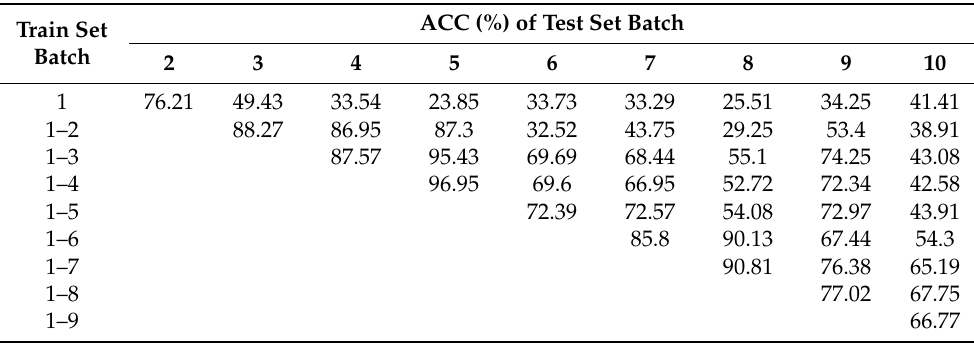
Table 4. The classification accuracy of only SVM (use batch 1-m as the training set and batch n as the testing set where m = 1, 2, . . . , 9 and n = m + 1, m + 2, . . . , 10).